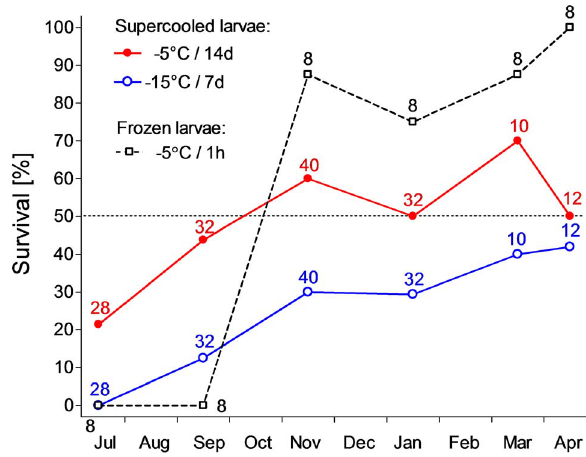
Figure 8. Cold tolerance. Survival at subzero temperatures in supercooled and partially frozen states in the field-sampled caterpillars of Cydia pomonella during 2010/2011. Each point is the percentage of survivors in a sample of n larvae ( n =flanking number). Supercooled larvae were exposed either to 2 5 u C for 14 d or to 2 15 u C for 7 d. Partially frozen larvae were exposed to 2 5 u C for 1 h.